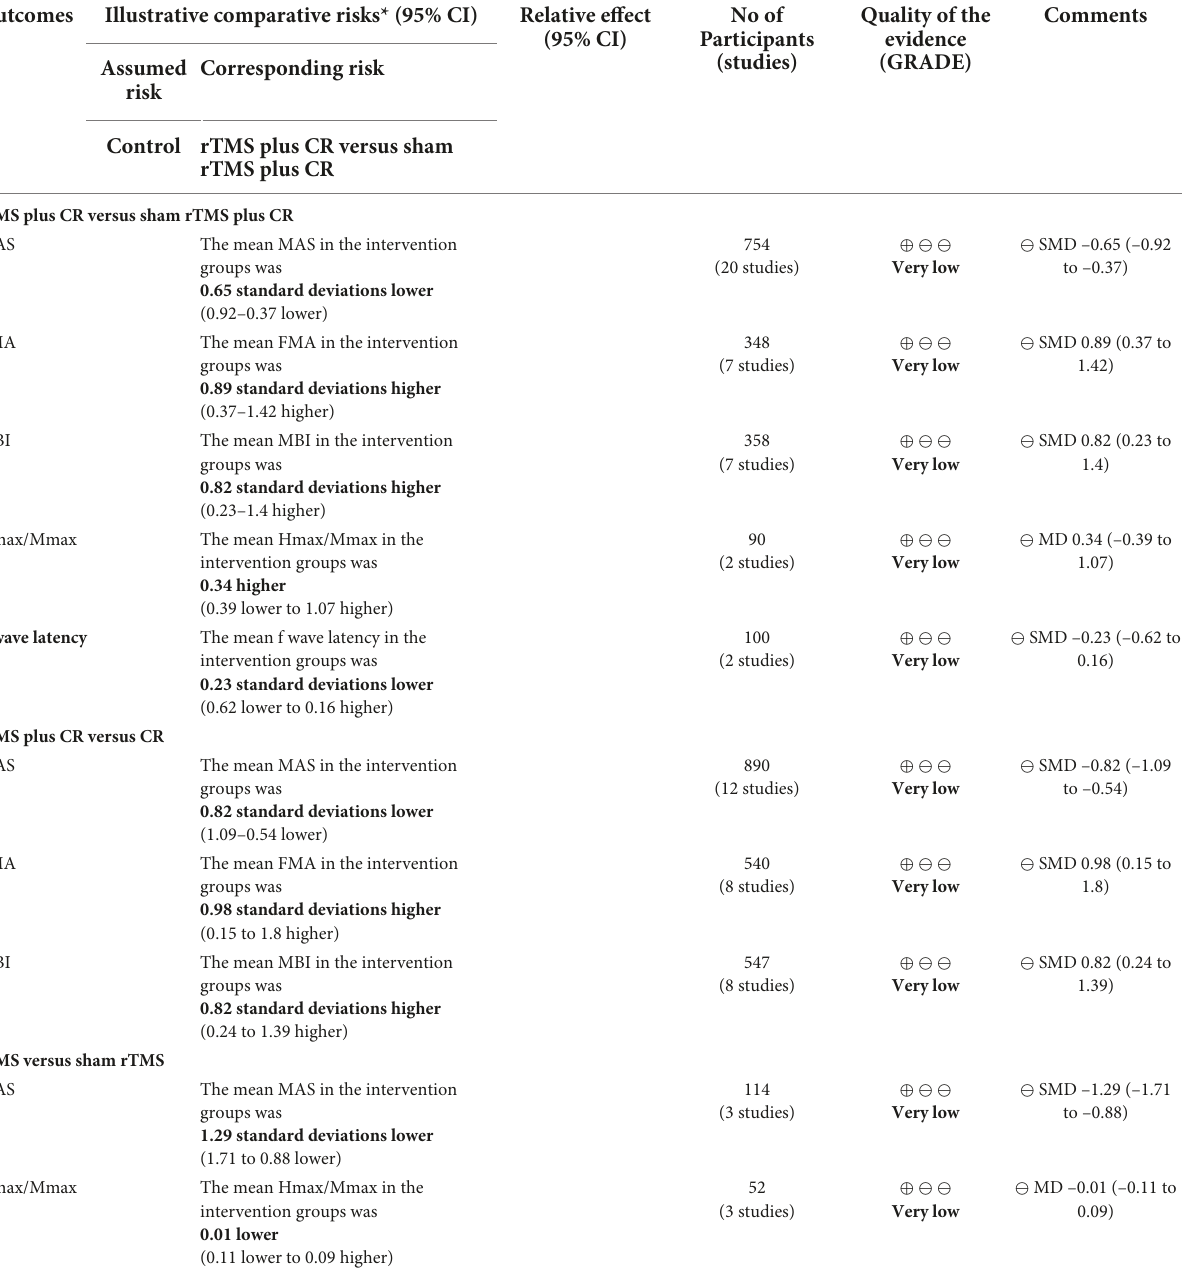
TABLE 4 The results of GRADE. Patient or population: patients with spasticity after UMN injury